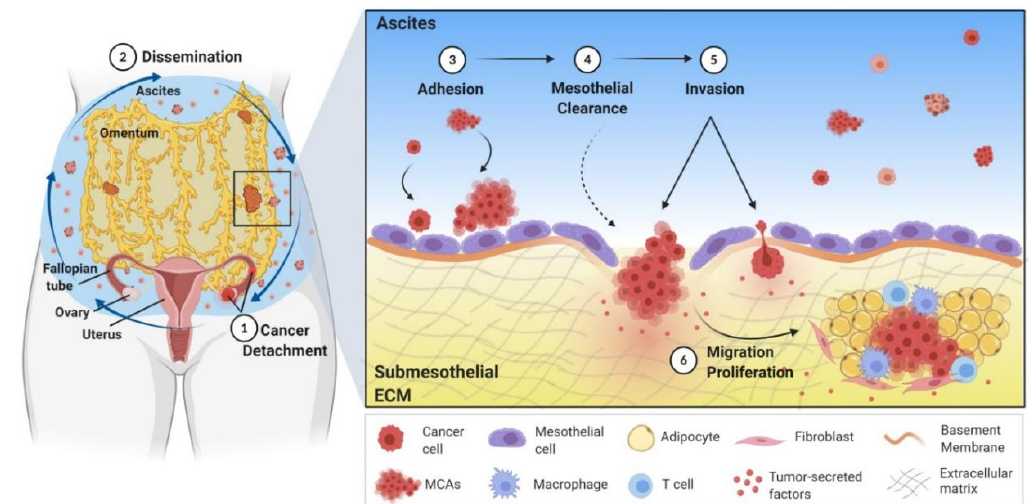
Figure 1. Transcoelomic dissemination model of ovarian cancer metastasis. (1) Ovarian cancer cells are exfoliated from the primary ovarian surface or fallopian tubes into the peritoneal cavity. (2) These detached single cells and multicellular aggregates (MCAs or spheroids) float in the peritoneal fluid or ascites and disseminate throughout the peritoneal cavity, as depicted by the blue arrows. Ovarian cancer cells and MCAs adhere to and implant on the peritoneum and peritoneal organs such as the omentum (3), where they clear the mesothelial lining (4), invade into the submesothelial extracellular matrix (ECM) (5), migrate and proliferate to form multiple distal metastatic tumors (6).